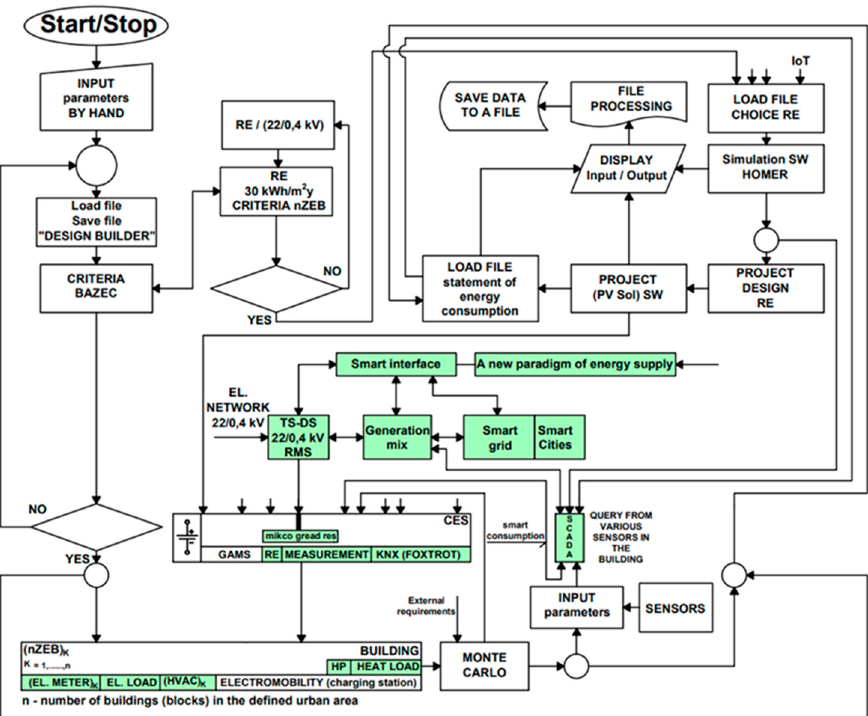
Figure 4. NZEB energy model with the application of automated systems of technical equipment of buildings.